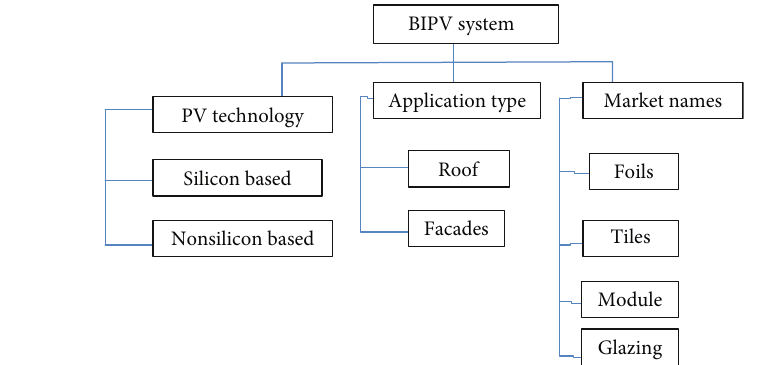
Figure 10: Categorization of BIPV [15, 66].